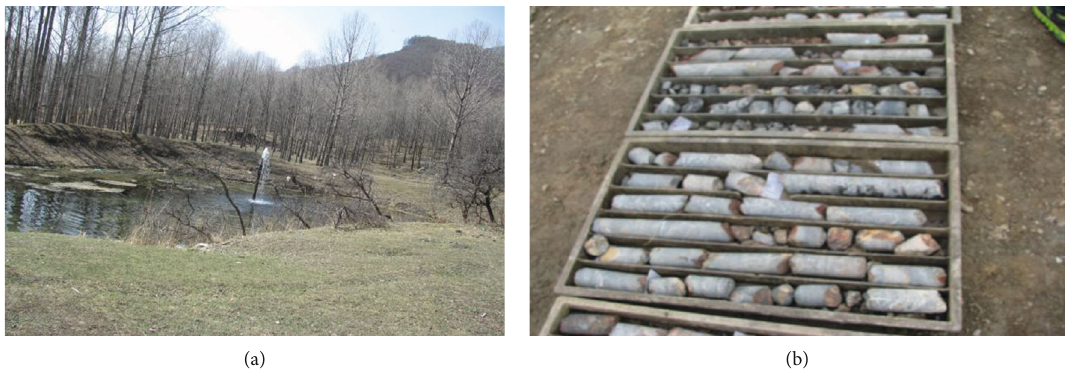
Figure 16: Photo of the groundwater fl owing borehole behind the dam (a) and core drilled on site (b).